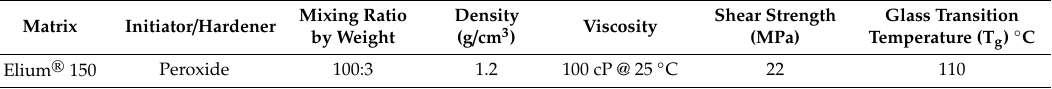
Table 1. Mechanical characteristic of the Elium ® 150 resin used in the current project [60,63].